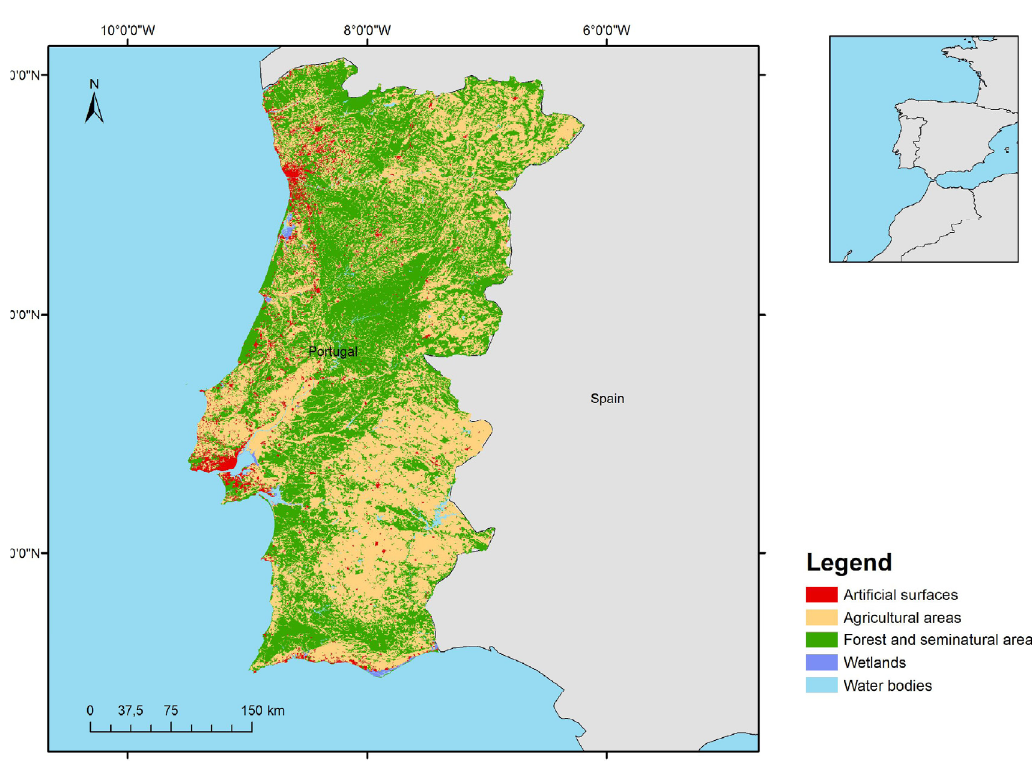
Figure 1 - Study area showing CORINE Land Use and Land Cover 2006 map of Continental Portugal. (see the colors in the online